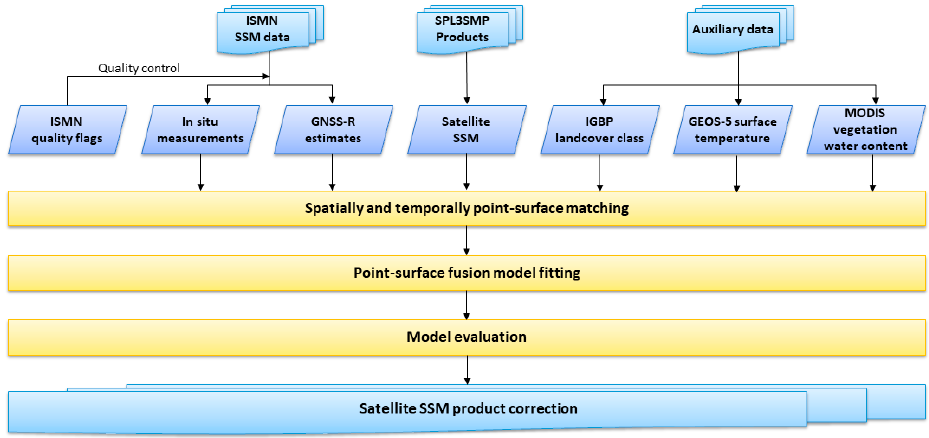
Figure 2. Data and flow chart of point-surface fusion scheme for satellite SSM quality improvement.